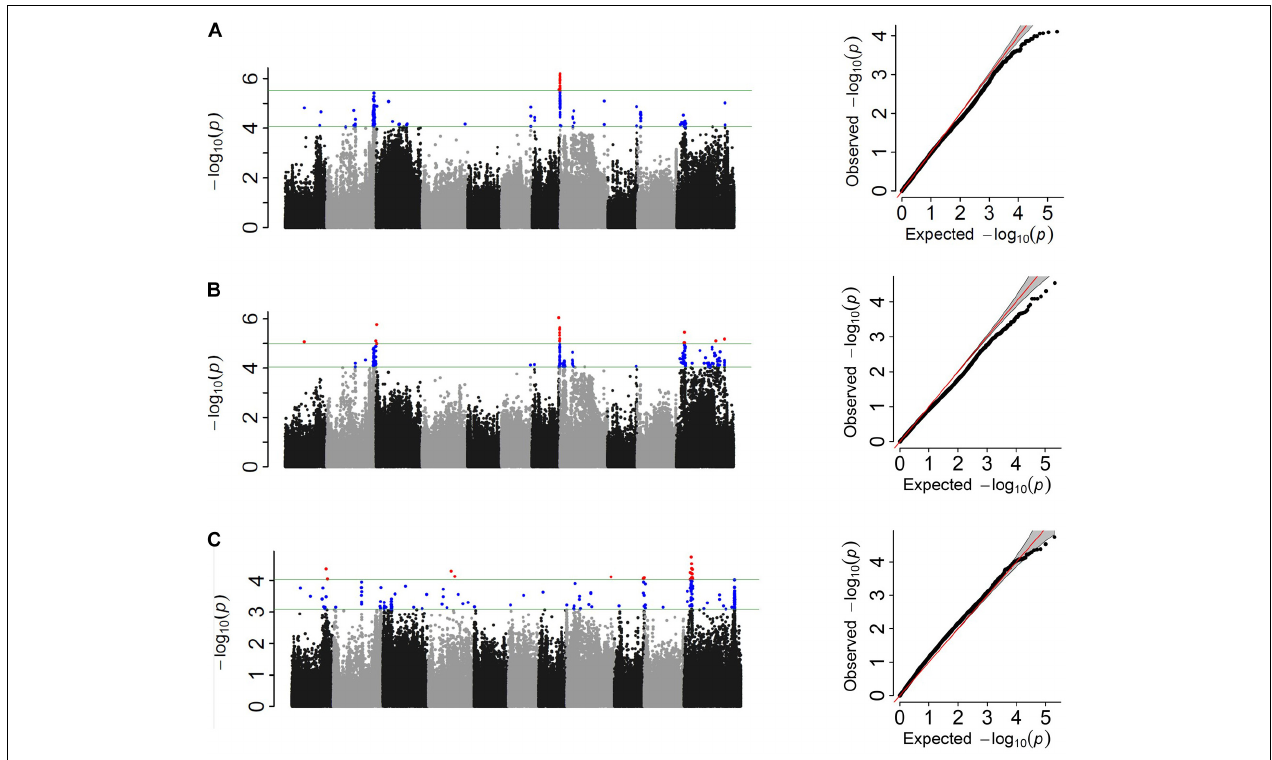
FIGURE 3 | Manhattan and corresponding Q–Q plots representing the genetic architecture of Fusarium solani resistance from GWAS analysis of (A) quantitative, (B) three-class, and (C) binary scoring systems in the Andean Diversity Panel (ADP).